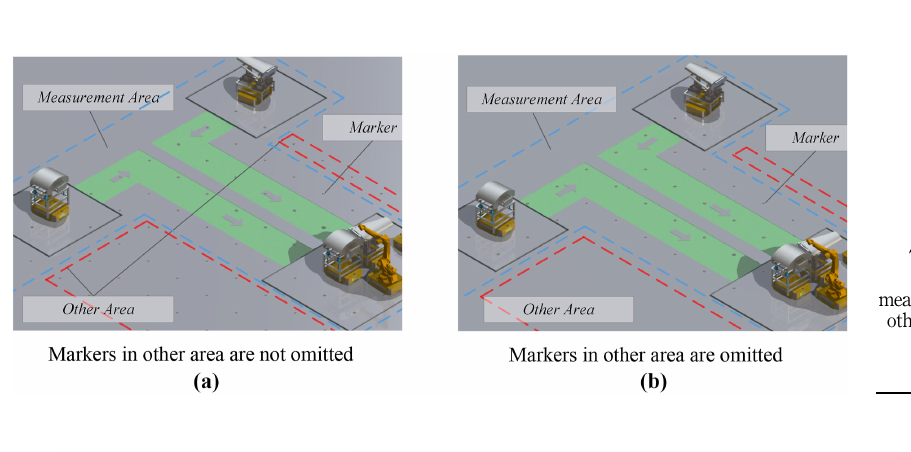
Figure 4. The whole scene is